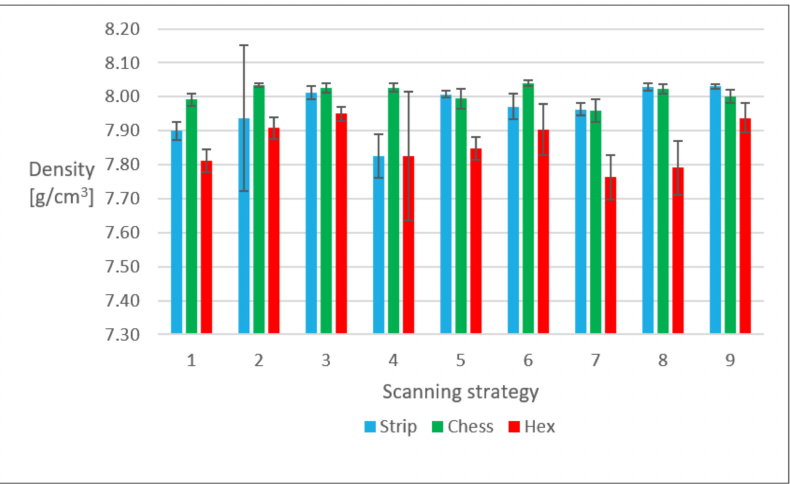
Figure 5. The average surface roughness Ra (average values and standard deviation) of the as-built specimens belonging to different sets of prints 1, 2 and 3.